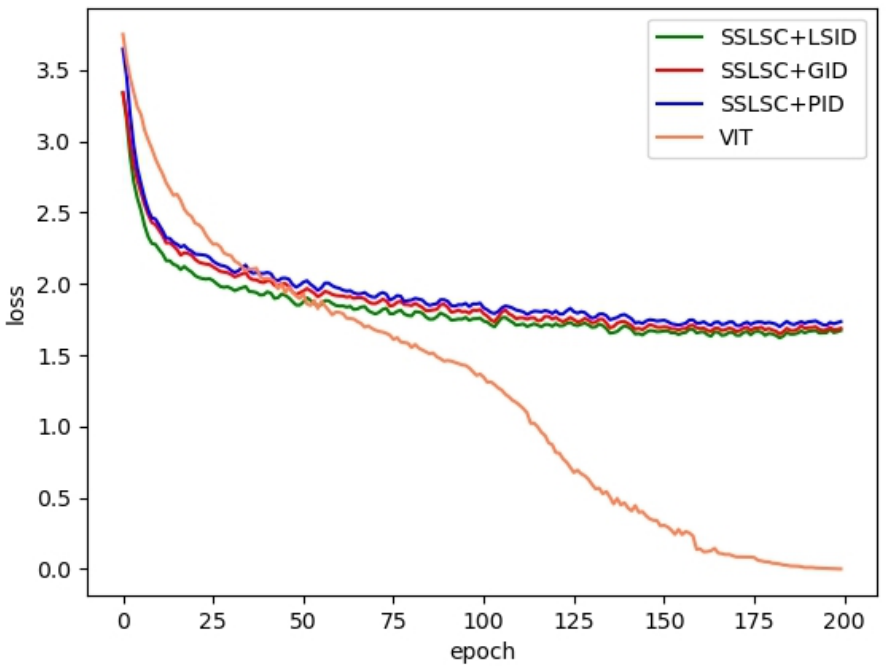
Figure 8. Train loss of our proposed method on AID